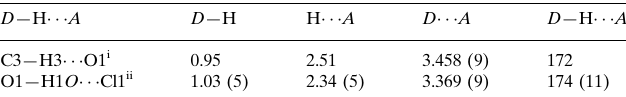
Hydrogen-bond geometry (A˚ , (cid:2)